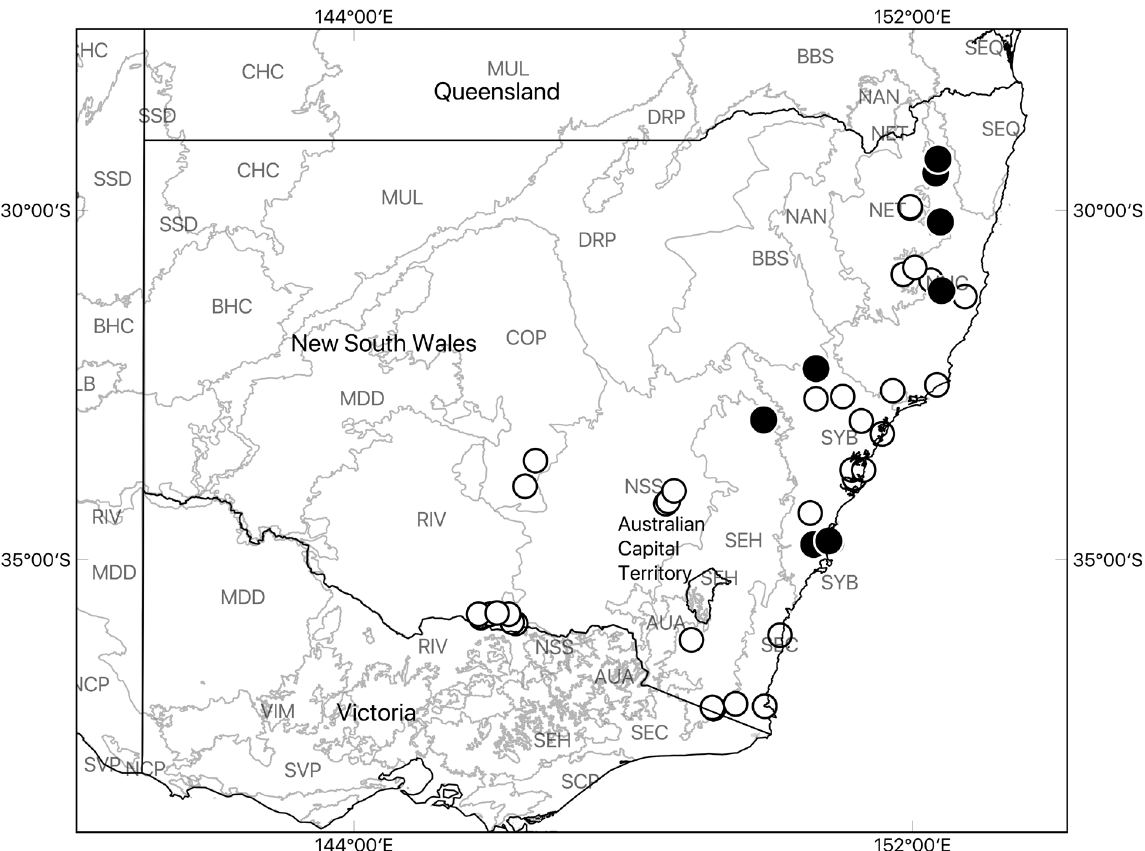
Figure 41. Distribution records of Artoria triangularis Framenau, 2002 (open circles) and A. ulrichi Framenau, 2002 (full circles) in NSW. IBRA bioregions with spider records: COP – Cobar Peneplain; NET New England Tablelands; NNC – NSW North Coast;